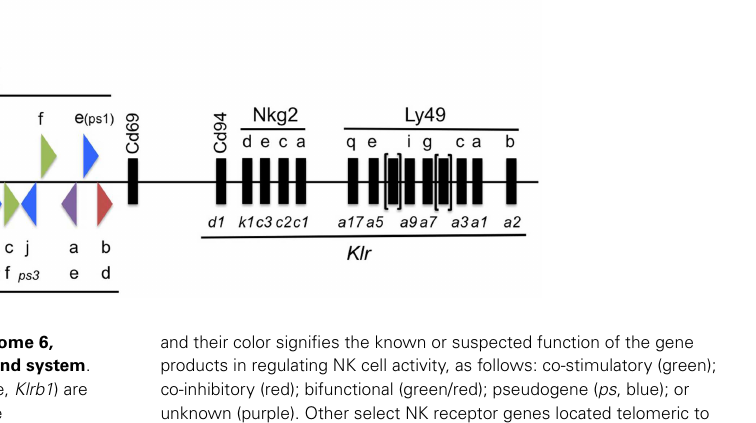
FIGURE 1 | Updated map of the NKC on mouse chromosome 6, highlighting the Nkrp1/ Klrb1 and Clr/ Clec2 receptor–ligand system . The mouse Nkrp1 receptor genes (official gene nomenclature, Klrb1 ) are highlighted at the top, with the Clr ligand genes (official gene nomenclature, Clec2 ) denoted below, located between the A2m and Cd69 genes (17).The triangles depict the gene orientation (plus or minus strand)